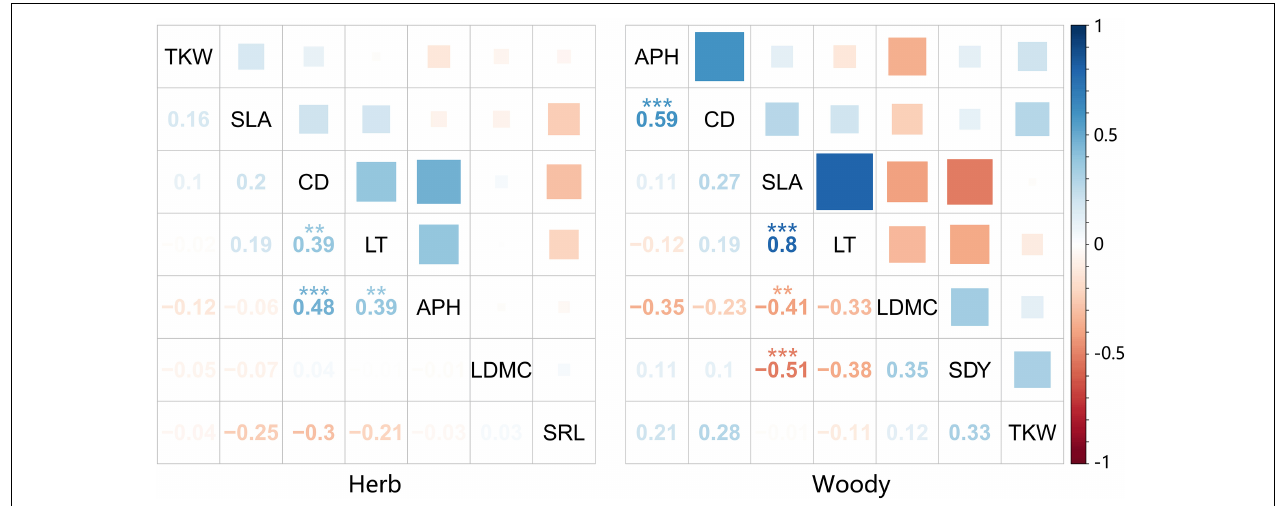
FIGURE 4 | Pearson’s correlation coefficients of functional traits at the community scale. SLA, specific leaf area; LDMC, leaf dry matter content; SRL, specific root length (for herbaceous plants only); SDY, stem density (for woody plants only); LT, leaf thickness; APH, average plant height; CD, crown diameter; TKW, thousand kernel weight; **, significant at the 0.05 level; ***, significant at the 0.01